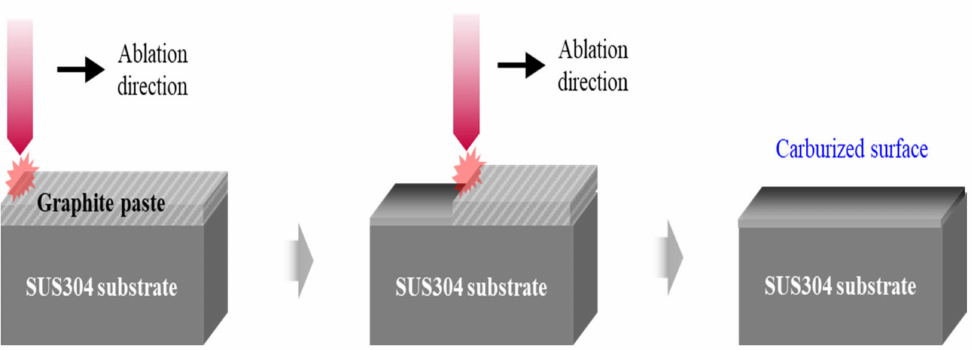
Figure 1. Schematic of laser carburization on